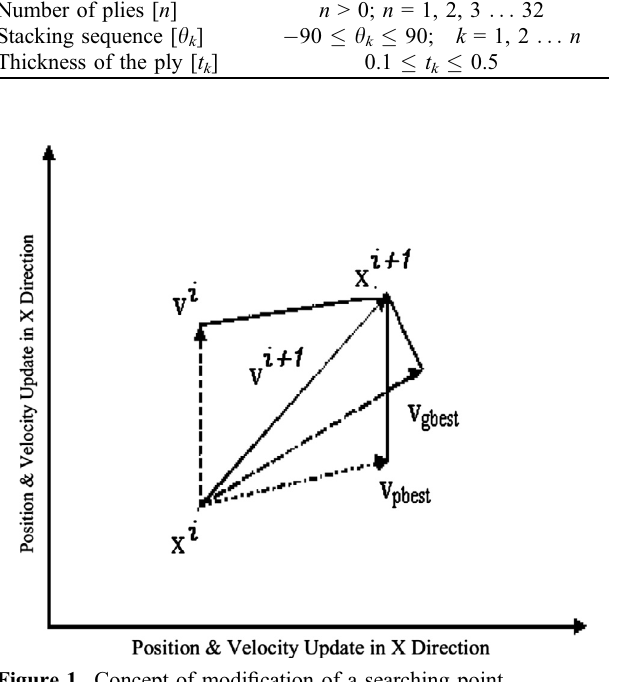
Figure 1. Concept of modification of a searching point.